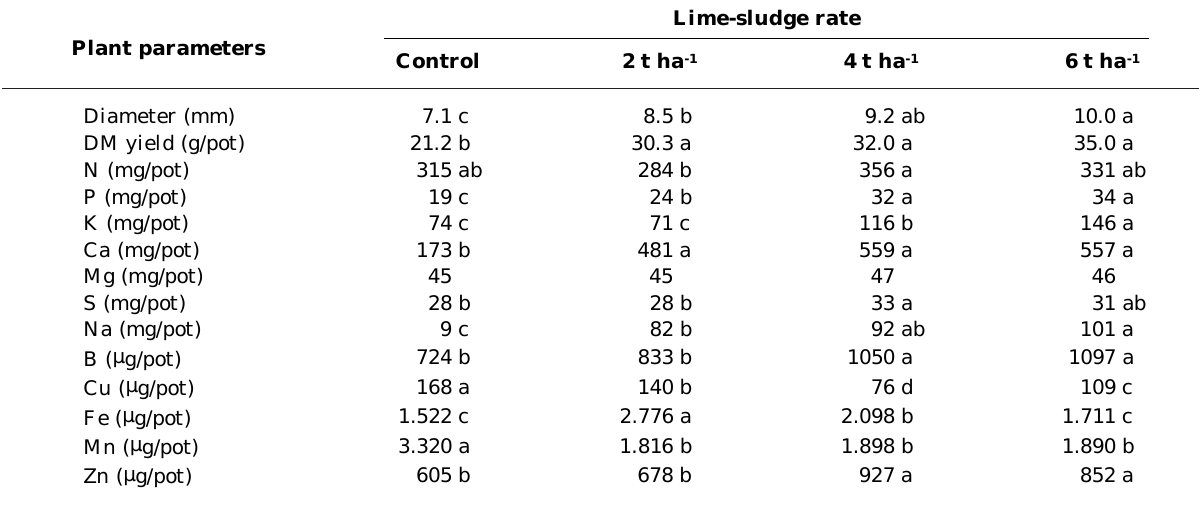
Table 5. Effect of lime-sludge rate on eucalypt diameter growth, dry matter yield and nutrient